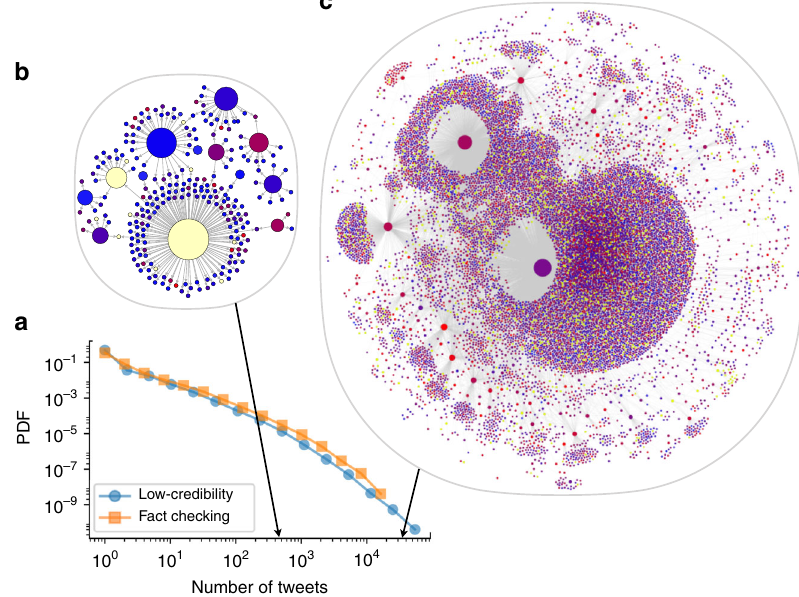
Fig. 1 Online virality of content. a Probability distribution (density function) of the number of tweets for articles from both low-credibility (blue circles) and fact-checking (orange squares) sources. The distributions of the number of accounts sharing an article are very similar (see Supplementary Fig. 2). As illustrations, the diffusion networks of two stories are shown: b a medium-virality misleading article titled “ FBI just released the Anthony Weiner warrant, and it proves they stole election ” , published a month after the 2016 US election and shared in over 400 tweets; and c a highly viral fabricated news report titled “ Spirit cooking ” : Clinton campaign chairman practices bizarre occult ritual, published 4 days before the 2016 US election and shared in over 30,000 tweets. In both cases, only the largest connected component of the network is shown. Nodes and links represent Twitter accounts and retweets of the article, respectively. Node size indicates account in fl uence, measured by the number of times an account was retweeted. Node color represents bot score, from blue (likely human) to red (likely bot); yellow nodes cannot be evaluated because they have either been suspended or deleted all their tweets. An interactive version of the larger network is available online (iunetsci.github.io/HoaxyBots/). Note that Twitter does not provide data to reconstruct a retweet tree; all retweets point to the original tweet. The retweet networks shown here combine multiple cascades (each a “ star network ” originating